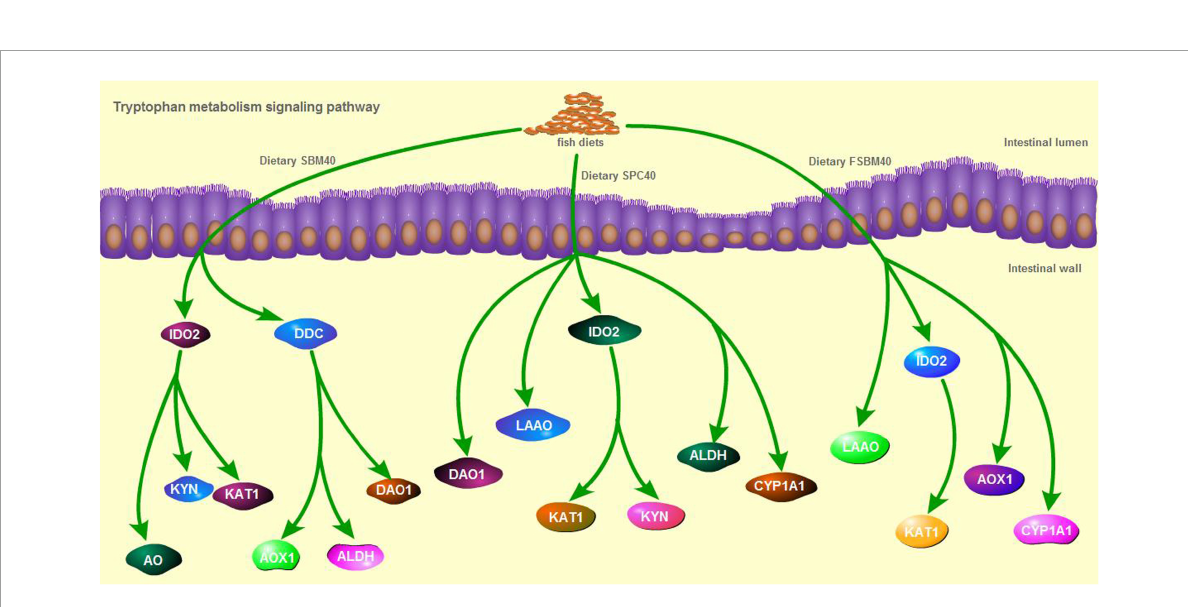
FIGURE6 The key genes inhibited in tryptophan metabolism pathway of different soy meals induced enteritis in pearl gentian grouper.